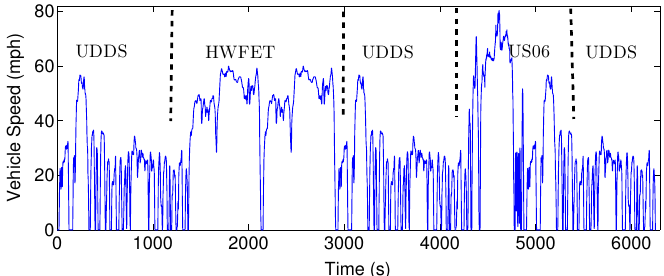
Figure 7. The combined driving cycle used for the evaluation of the designed energy management control